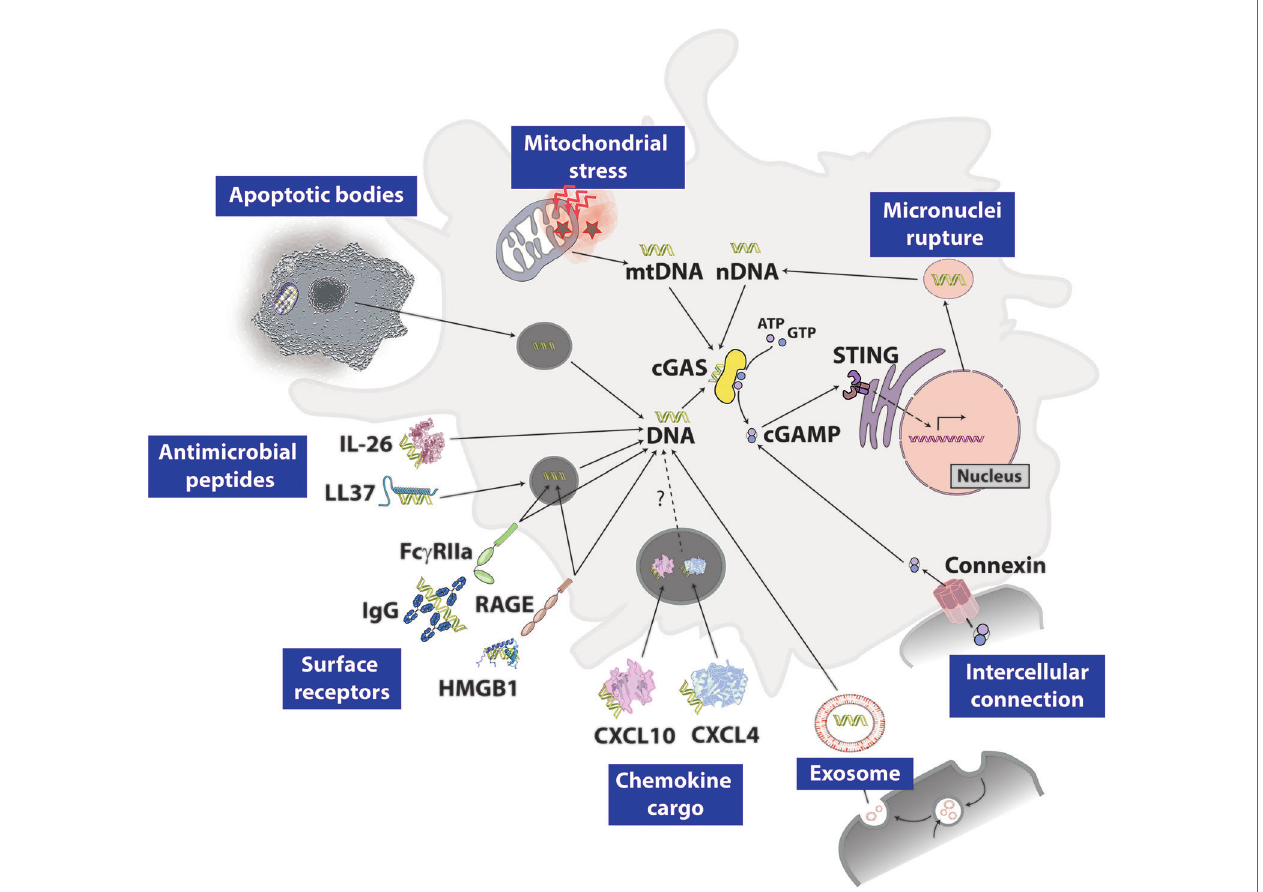
FIGURE 2 | Proposed mechanism for self-DNA access to the cytoplasm. Mitochondrial stress-induced membrane permeability with mitochondrial DNA (mtDNA) leakage and chromosomal instability/senescence lead to micronucleus formation from incomplete segregation of chromatin and micronucleus rupture induces cytosolic nuclear DNA (nDNA). Multiples pathways lead to self-DNA internalization within endosomal structures and we believe that endosomal pathway perturbation leads to cytosolic delivery of DNA and cGAS/STING pathway activation. Apoptotic bodies engulfment may enable self-DNA delivery in the cytoplasm. The antimicrobial peptide LL37 and IL-26 bind to genomic DNA and induce its translocation within endosomes and/or in the cytoplasm. CXCL4- and CXCL10-DNA complexes as well as cell surface receptors Fc g RIIa or receptor for advanced glycation end products (RAGE) bind to IgG- or HMGB1-bound DNA, respectively, and may lead to cGAS activation upon cytosolic DNA release. DNA-containing exosomes constitute another source of cGAS activation. Finally, cGAMP enters the cell from neighboring ones through gap junctions to directly activate